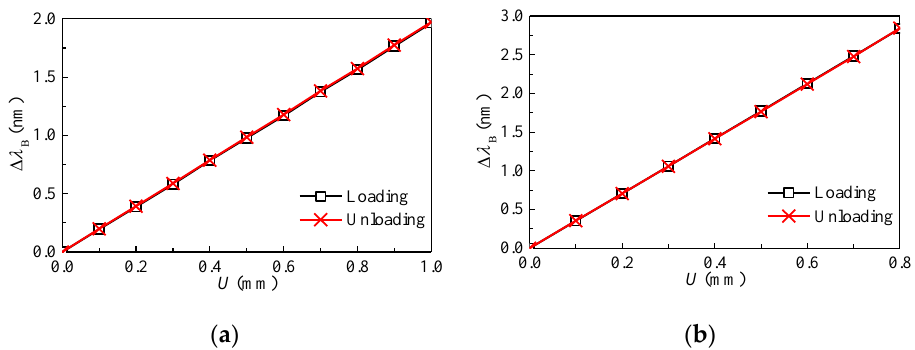
Figure 7. Relationship between the diametral displacement of ring and the wavelength shift of FBG. ( a ) Ring with a thickness of 0.6 mm; ( b ) ring with a thickness of 1.0 mm.